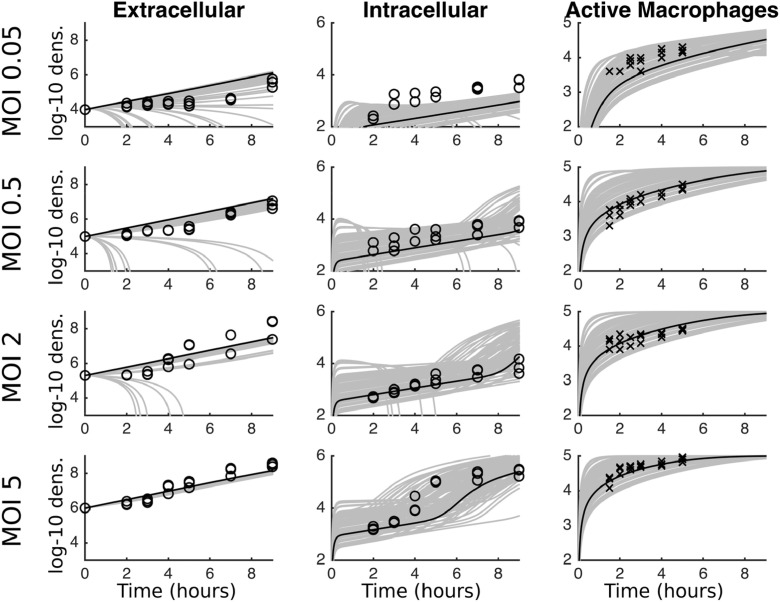
Experimental data (circles for bacteria data, crosses for macrophage data) and mathematical model fits for four MOIs. In each case the x-axis represents time in hours, and the y-axes are the log-10 densities. The black solid line gives the mean values from the posterior distributions in Fig. 2. The grey lines show 100 runs with the threshold values for ingestion, cβ, and killing, ck chosen from the respective posterior distributions.